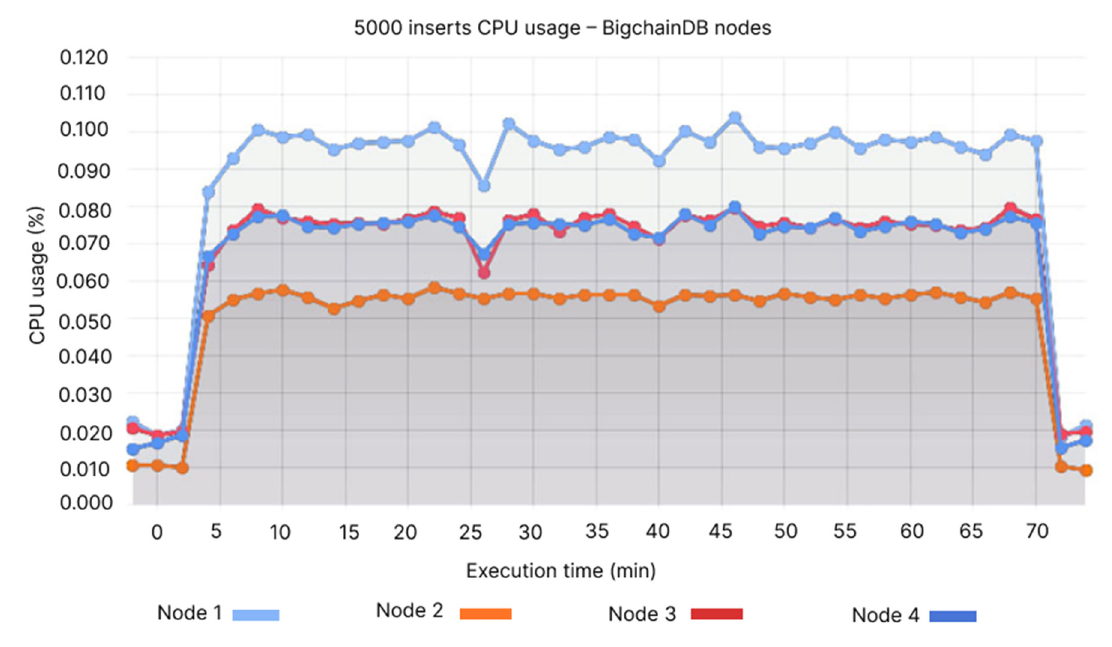
Figure 10. 5000 inserts CPU usage—BigchainDB nodes.